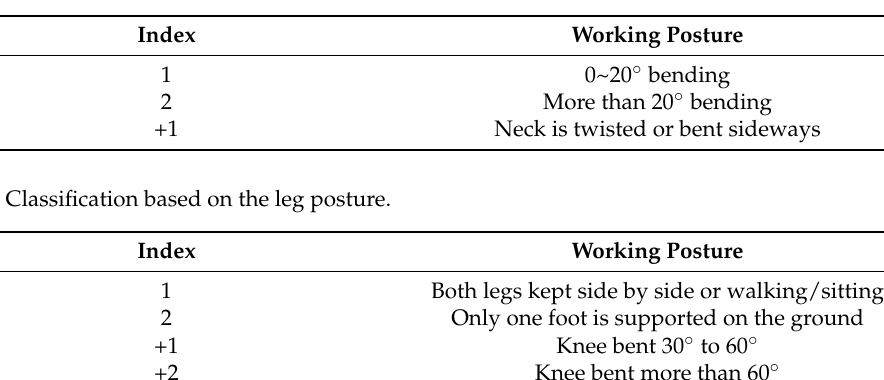
Table 5. Classification based on the neck posture.